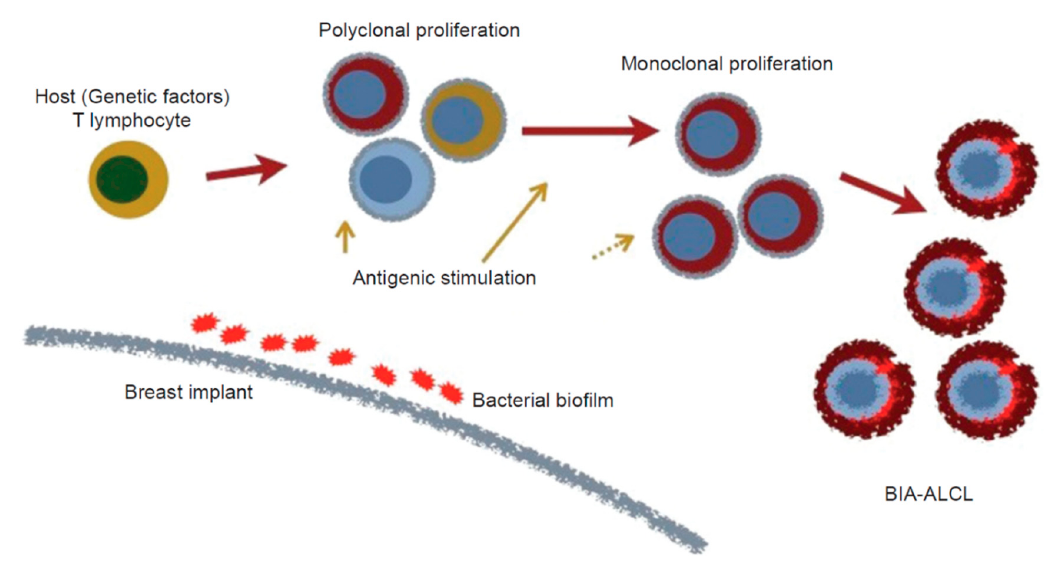
Figure 3. Proposed hypothesis for the genesis of BIA-ALCL [101].